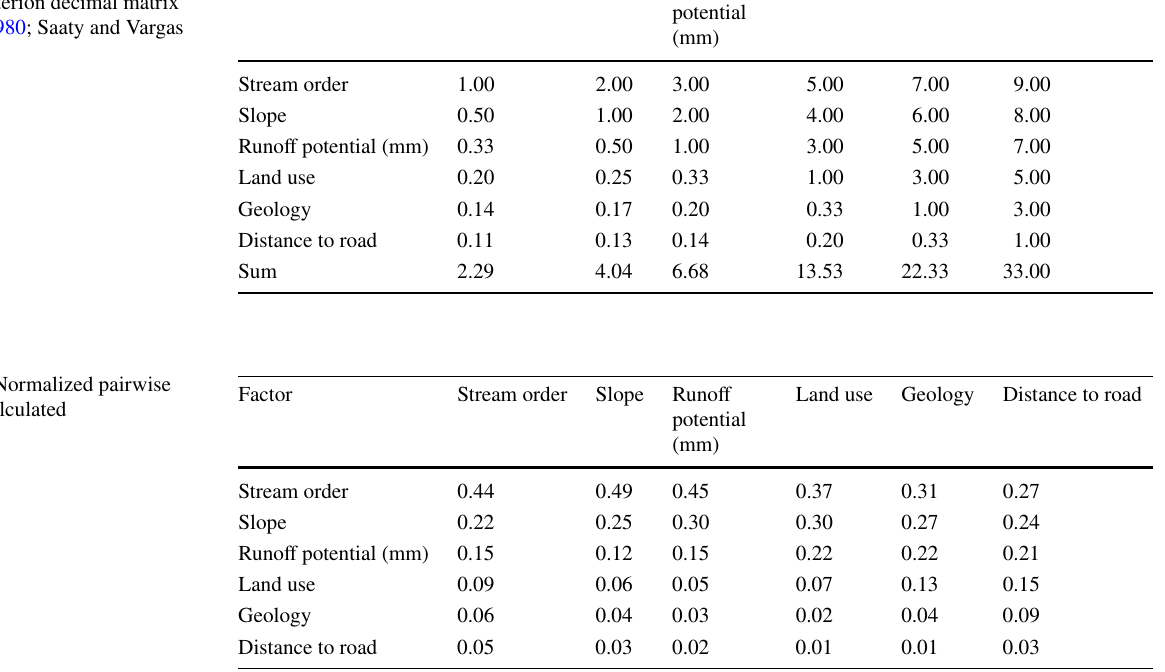
Table 6 Pairwise comparison of seven criterion decimal matrix (Saaty, 1980; Saaty and Vargas 1991)